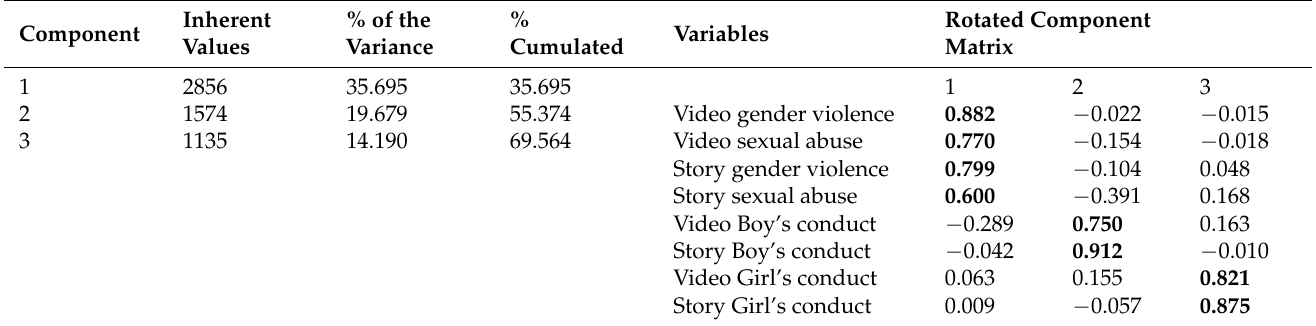
Table 2. Factorial analysis. Bold components correspond to the original variables with higher weight in each factor.